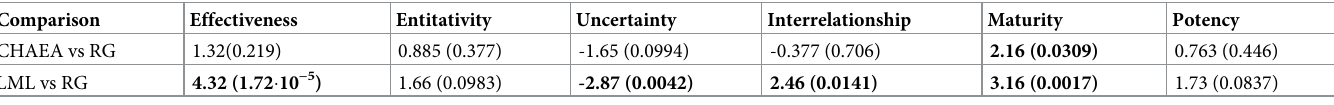
Table 1. Performance of Minimum Entropy Collaborative Groupings (CHAEA or LML) compared to Random groups (RG).